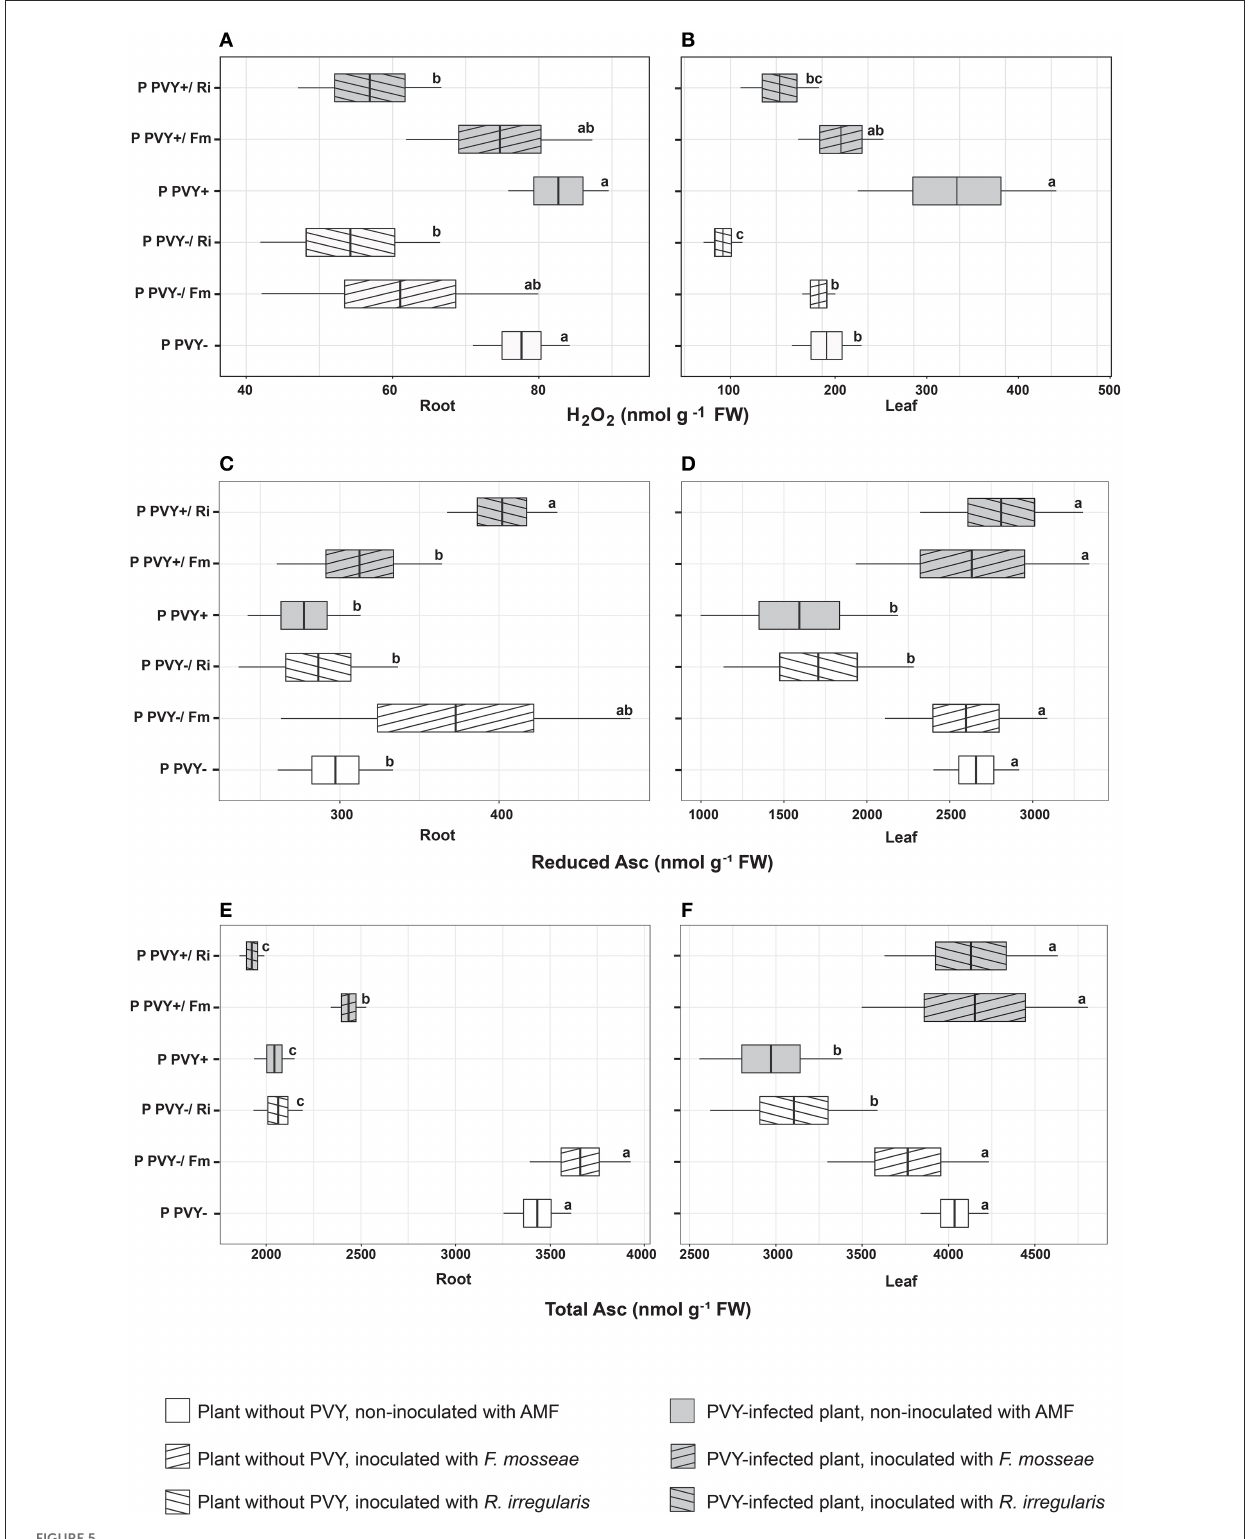
FIGURE5 The combined effect of AMF inoculation and PVY infection on oxidative stress indicators—hydrogen peroxide (A, B) , reduced ascorbate (C, D) and total ascorbate level (E, F) in roots and leaves of in healthy and virus-infected potatoes. The statistically significant differences are marked with letters. The same letters indicate no significant differences ( p >